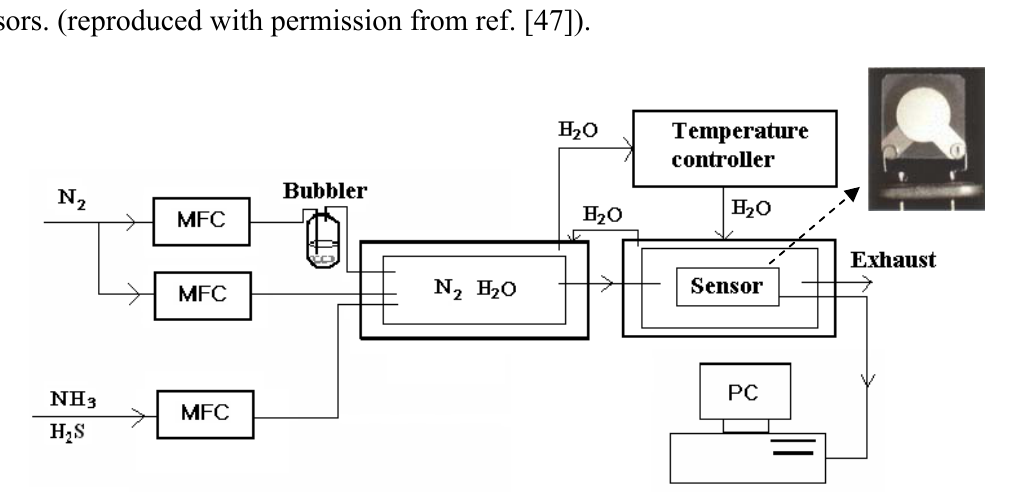
Figure 2. Schematic of a flow-type gas testing system for polyelectrolyte nanofiber gas sensors. (reproduced with permission from ref.